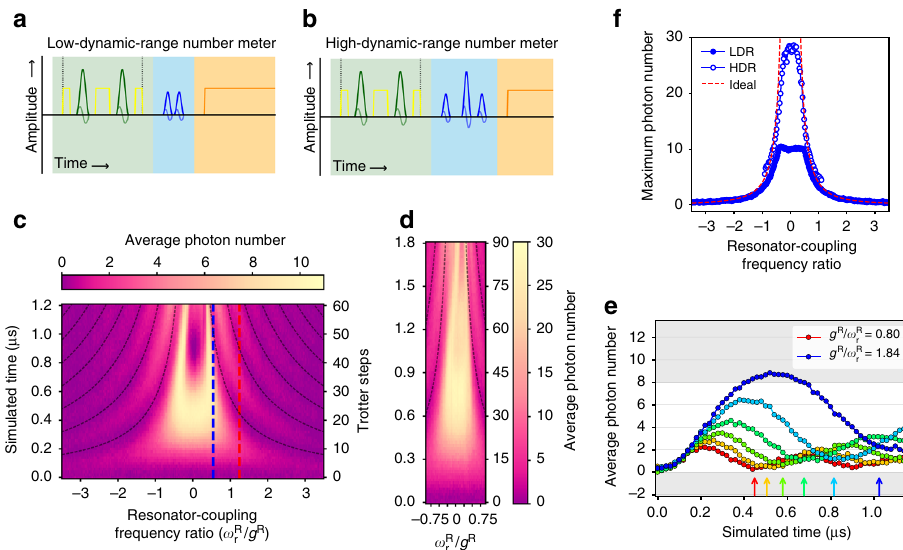
Fig. 3 Photon number dynamics of the quantum Rabi model in the degenerate-qubit case. a , b Average photon number is probed by applying Ramsey and echo-like pulses to Q W . The effective Ramsey pulse separation τ determines the photon dynamic range. Because of fi nite pulse widths, reaching the small τ needed for high dynamic ranges b requires an unbalanced ‘ echo ’ -like sequence. c , e Measured photon number dynamics up to 60 Trotter steps using a low-dynamic-range (LDR) photon number meter ( τ (cid:1) 18 : 7 ns) with a linear range of ∼ 0 – 8 photons (indicated by grey regions in e ). Large photon populations in the resonator highlight the non-conservation of excitation number in the quantum Rabi model. The resonator displays clear oscillations up to r > 1.8 in good agreement with the expected qubit revival times (dashed curves). The red feature in the middle re fl ects the upper limit on the number meter ’ s dynamic range set by Q W ‘ population wrapping ’ at high photon numbers. d Measured photon dynamics up to 90 Trotter steps using a high- dynamic-range (HDR) number meter with τ (cid:1) 6 : 5 ns and a linear range of ∼ 0 – 20 photons, allowing observation of photon oscillations beyond 1.5 μ s of simulated time (more than 75 Trotter steps). This data shows the effect of a residual Kerr nonlinearity at high values of r . e Line slices are plotted for evenly spaced resonator-coupling frequency ratios between the red and blue dashed lines shown in c . Grey regions delineate the linear range of the number meter. f Maximum measured average photon number for each value of r for both LDR and HDR number